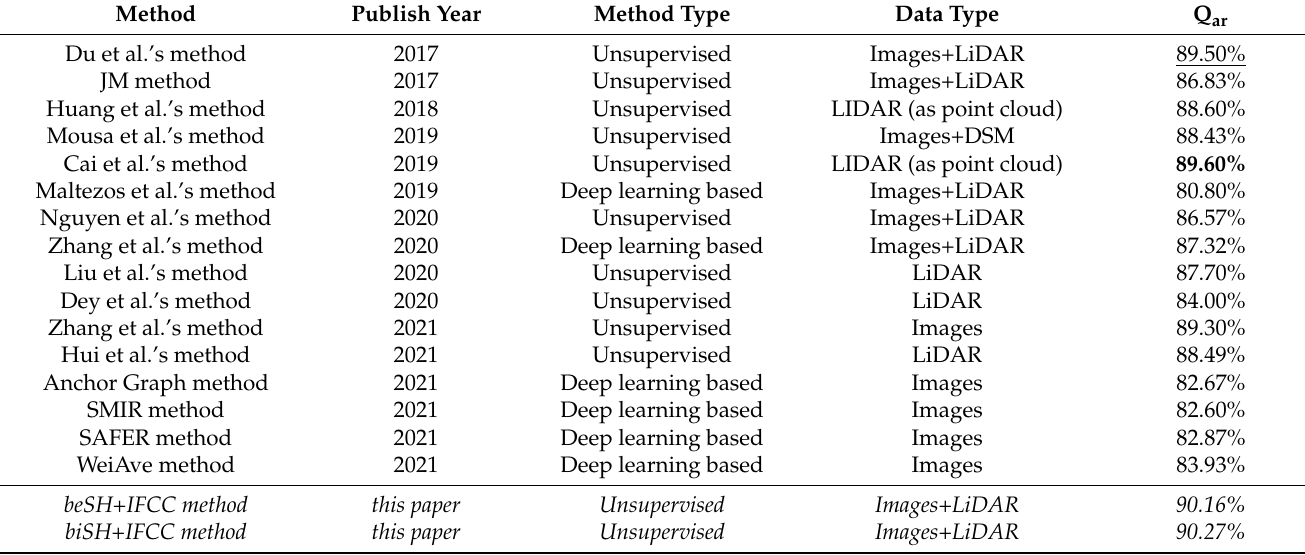
Table 7. Comparisons with state-of-the-art results in existing